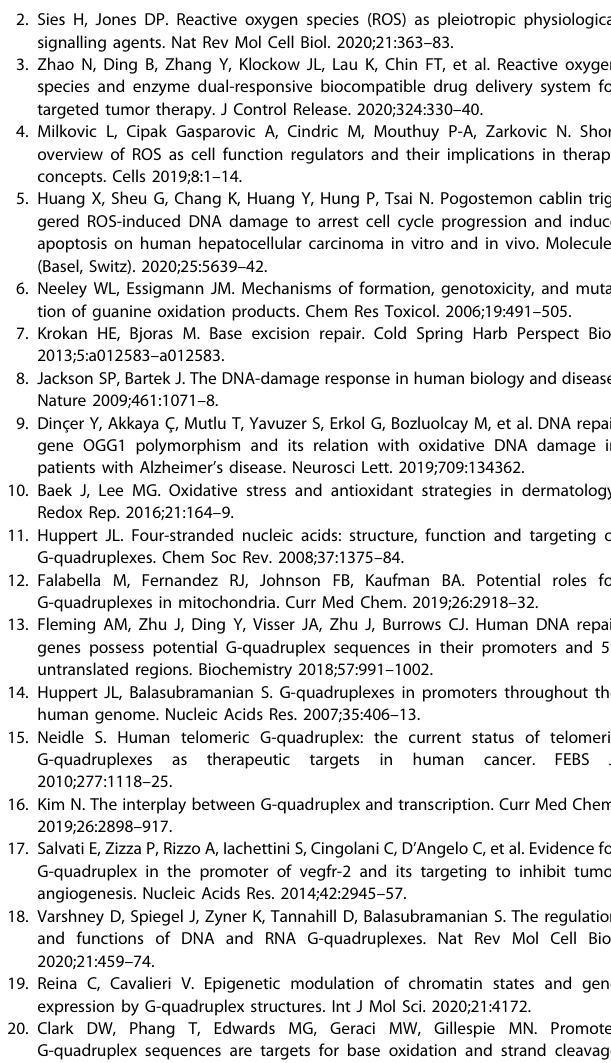
Fig. 8 Proposed involvement of G4 in Neurodegenerative diseases. As a key pathogenic gene of ALS/FTD, G4-forming in the promoter region of C9orf72 can inhibit its transcription. In particular, G4s also recruits hemin, leading to DNA oxidative damage. Formation of G4s in the promoter of Gad1 and Th inhibit their transcription and further affects the synthesis of GABA and Dopamine. G4 formed in the 5 ′ UTR region of α -SnCA, ADAM mRNA, and the 3 ′ UTR region of APP mRNA can directly inhibit translation. However, G4 formed in the BACE1 mRNA 3 ′ UTR region can recruit heterogeneous nuclear ribonucleoprotein H (hnRNPH), promote its translation, and induce the formation of APP, which are involved in the pathogenesis of AD and